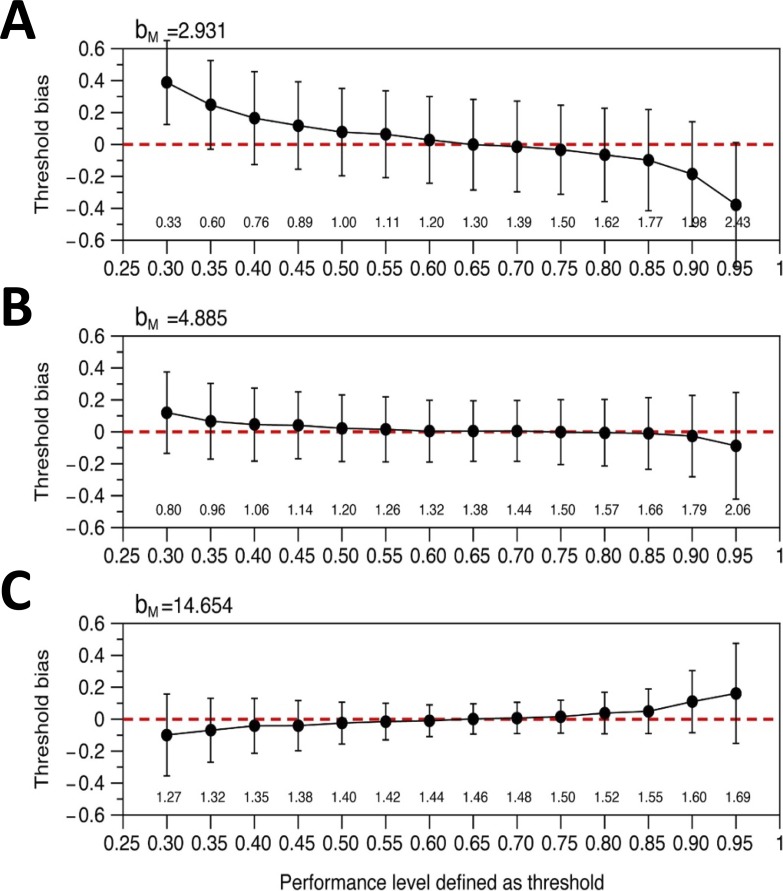
How accuracy and precision of threshold estimates depends on the level defined as threshold performance. The horizontal axis shows Θ, the proportion of correct answers defined as “threshold” (see Equation 8) and (above) the corresponding disparity values in log10 units. The vertical axis on each plot shows the bias in estimated threshold, that is, the difference between the threshold estimate returned after 20 trials and the model's true threshold θm, expressed in log10 stereo threshold units. By definition, Ψ(θm) = Θ. Black dots show the mean threshold estimate of 2000 simulated staircase procedures, as described in the Methods. Error bars show the standard deviation. The bias is close to zero, and the standard deviation is roughly constant, over a wide range of Θ (∼50%–80%). The staircase assumes the psychometric function given by Equation 9 with b = 4.885/log10 arcsec, λ = 0.03, g = 0.25, and Θ specified by the horizontal axis. The model observer is assumed to have a psychometric function with the same form and the same values of λ and g, but different slope parameters bM, as specified in each panel.